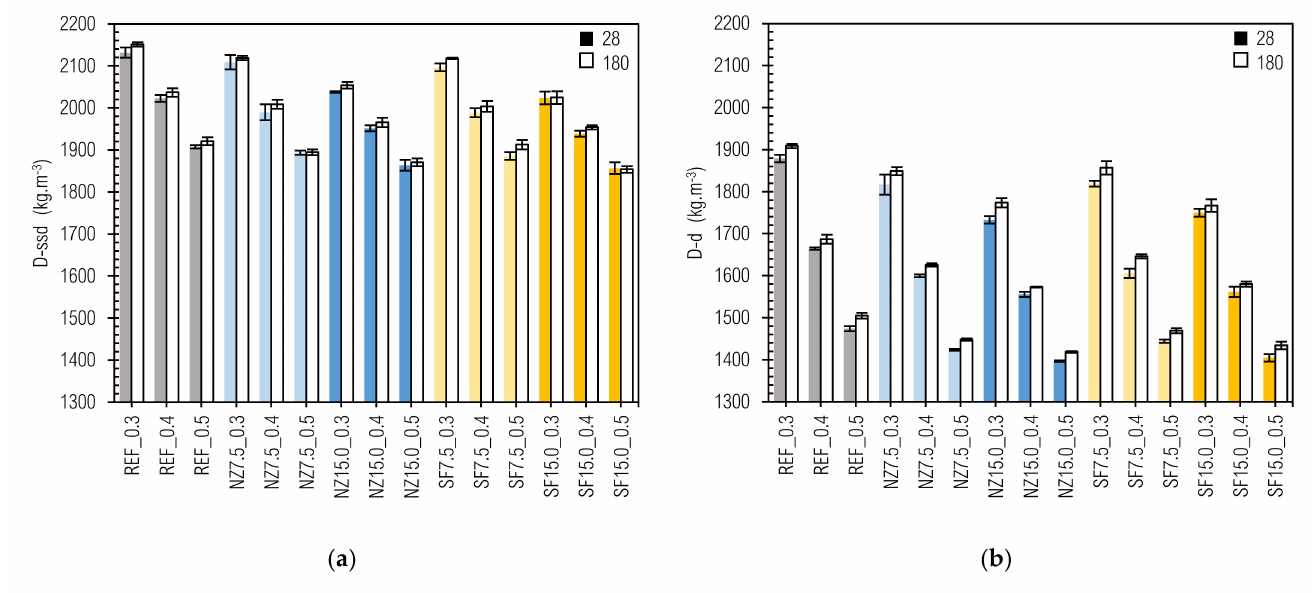
Figure 5. Densities of hardened cement pastes (CP): ( a ) ssd state; ( b ) oven-dried